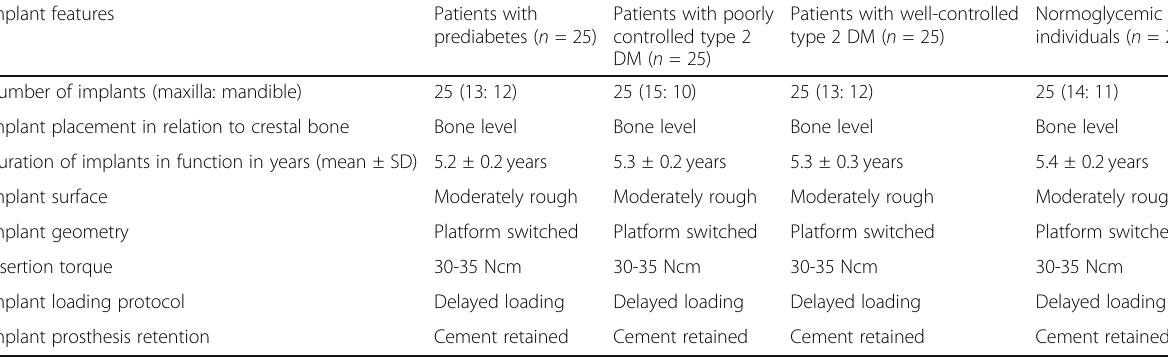
Table 2 Characteristics of the narrow-diameter implants placed in patients with prediabetes and type 2 diabetes mellitus and normoglycemic individuals Implant